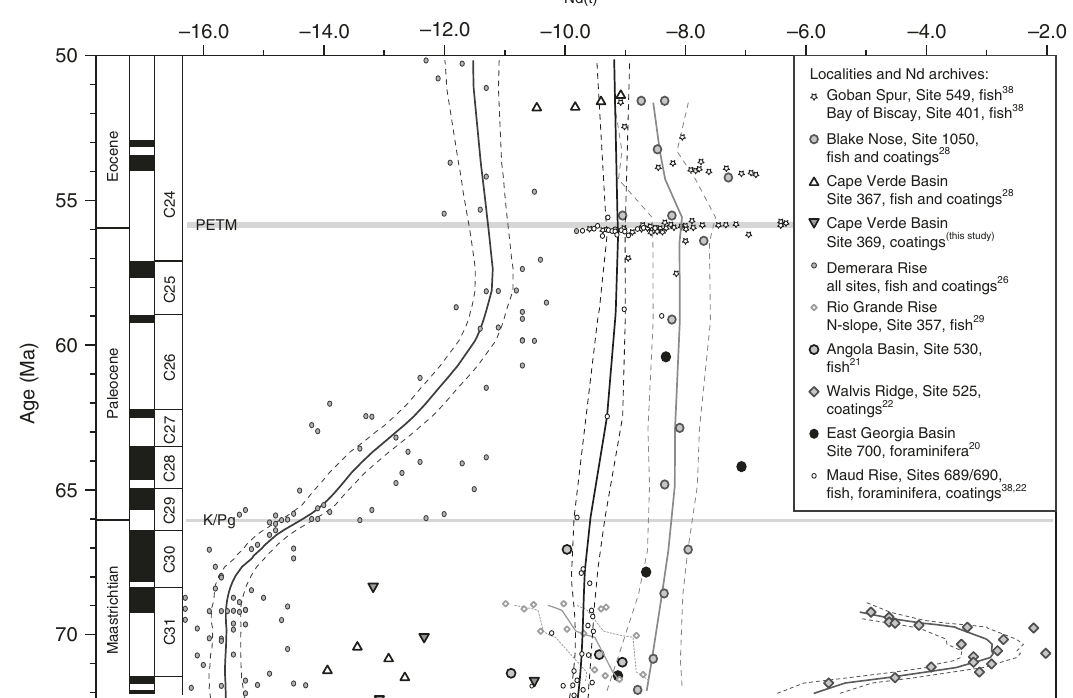
Fig. 1 Nd-isotope data across the latest Cretaceous – early Paleogene. In this compilation of published Atlantic ε Nd(t) records and new Nd-isotope data from Site 369 (this study) only records with four or more data points over the time-interval 72 – 50 Ma are included. The ε Nd(t) data of Demerara Rise (Sites 1258, 1260, 1261), Maud Rise, Blake Nose and Site 525 have been smoothed by LOWESS regression ( f = 0.3) with the dashed lines representing the 97.5% con fi dence interval. The ε Nd( t ) data are fl anked by the geomagnetic polarity time scale with chrons C31-C24. PETM: Paleocene/Eocene thermal maximum, K/Pg: Cretaceous/Paleogene